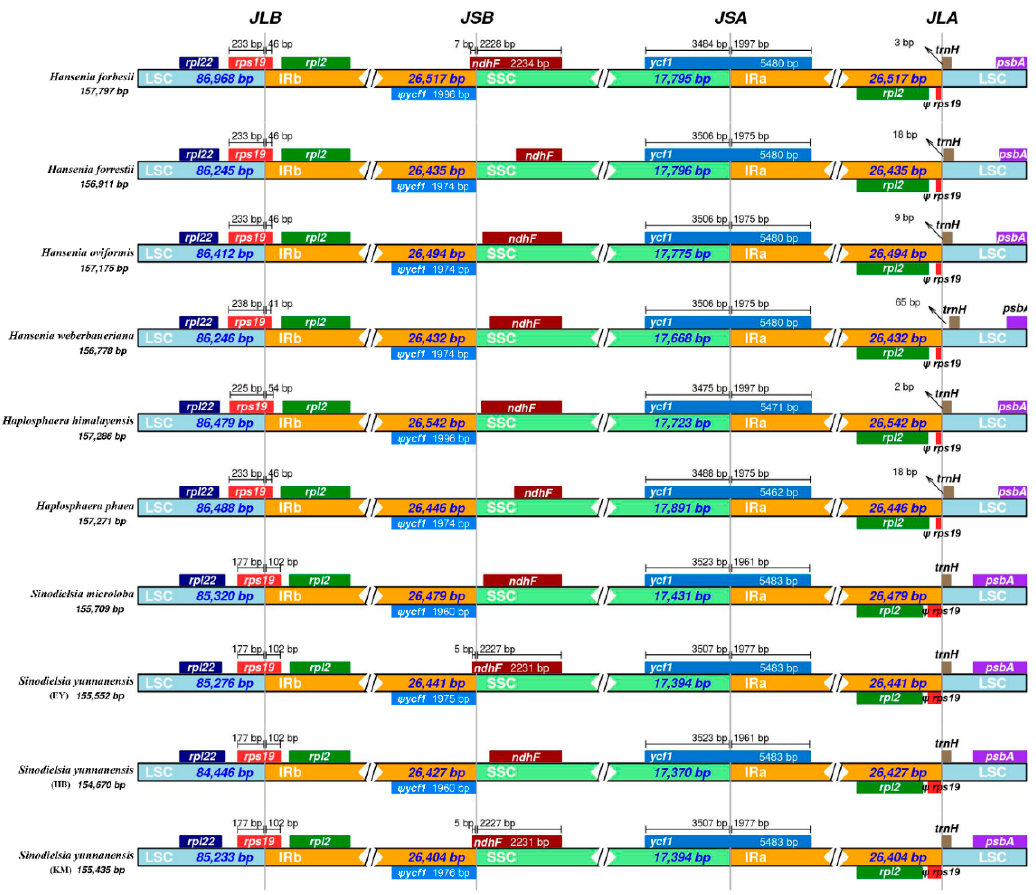
Figure 4. Comparisons of inverted repeat (IR) boundaries between ten Hansenia , Haplosphaera and Sinodielsia plastid genomes.